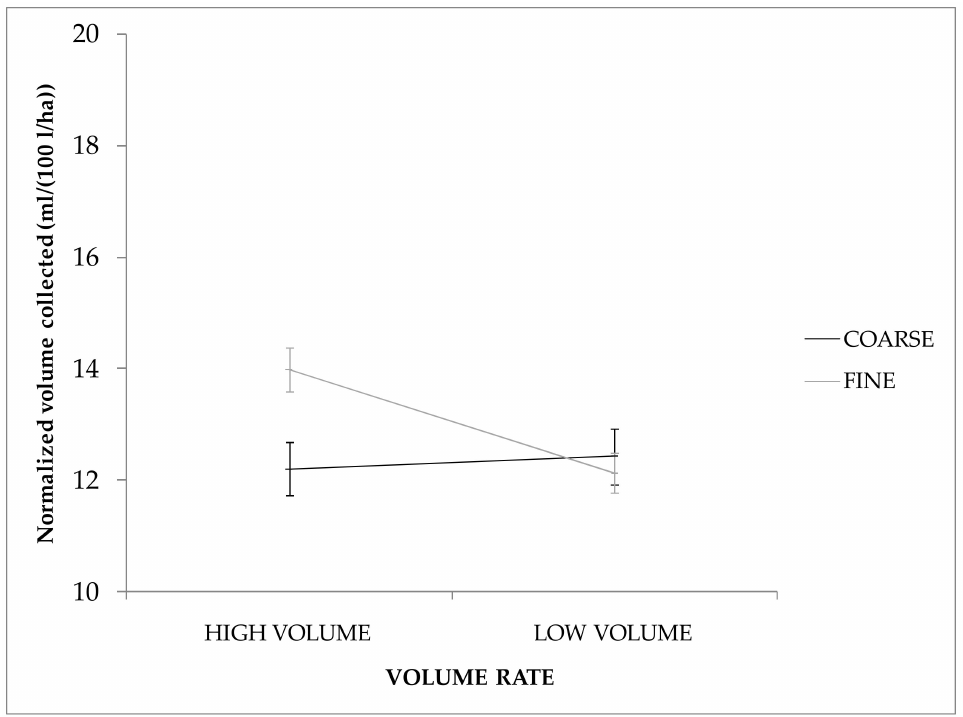
Figure 18. Volume rate × Nozzle type interaction effect on the normalized volume collected in the canopy zone (mean ± SE) with the C1 sprayer.